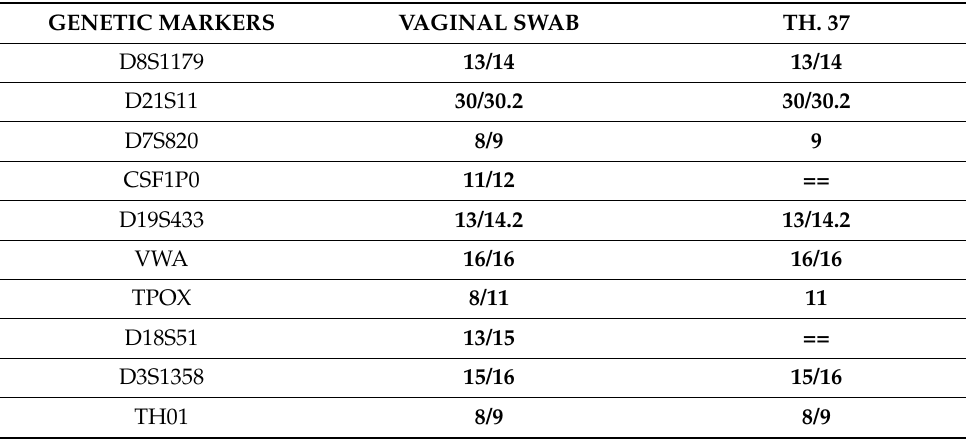
Table 2. Genetic markers were extracted from tooth No. 37 and a vaginal swab. GENETIC